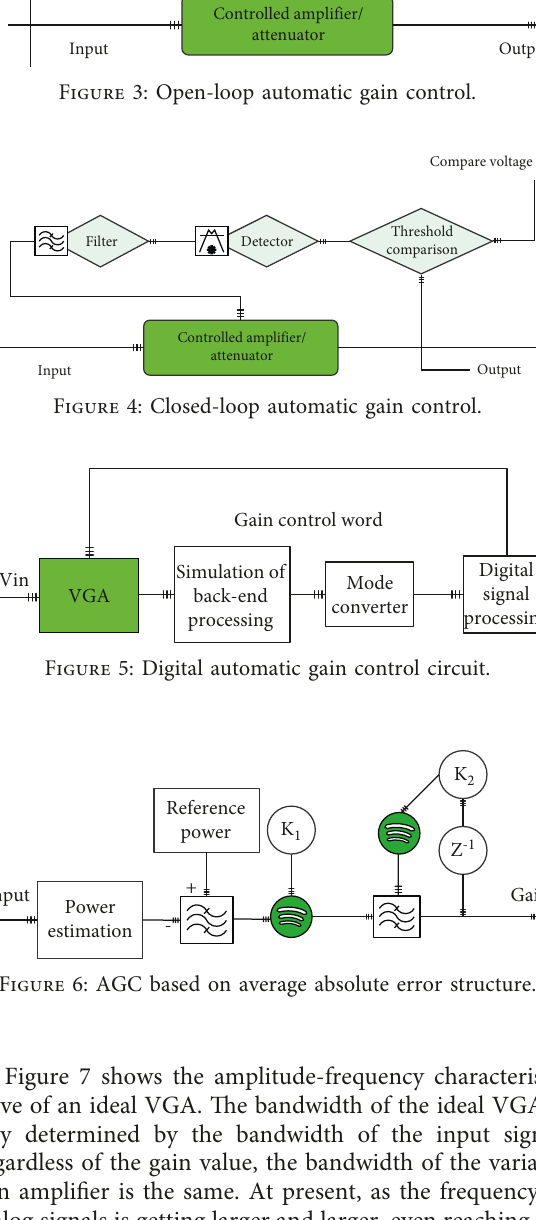
Figure 9: Automatic gain control loop with logarithmic